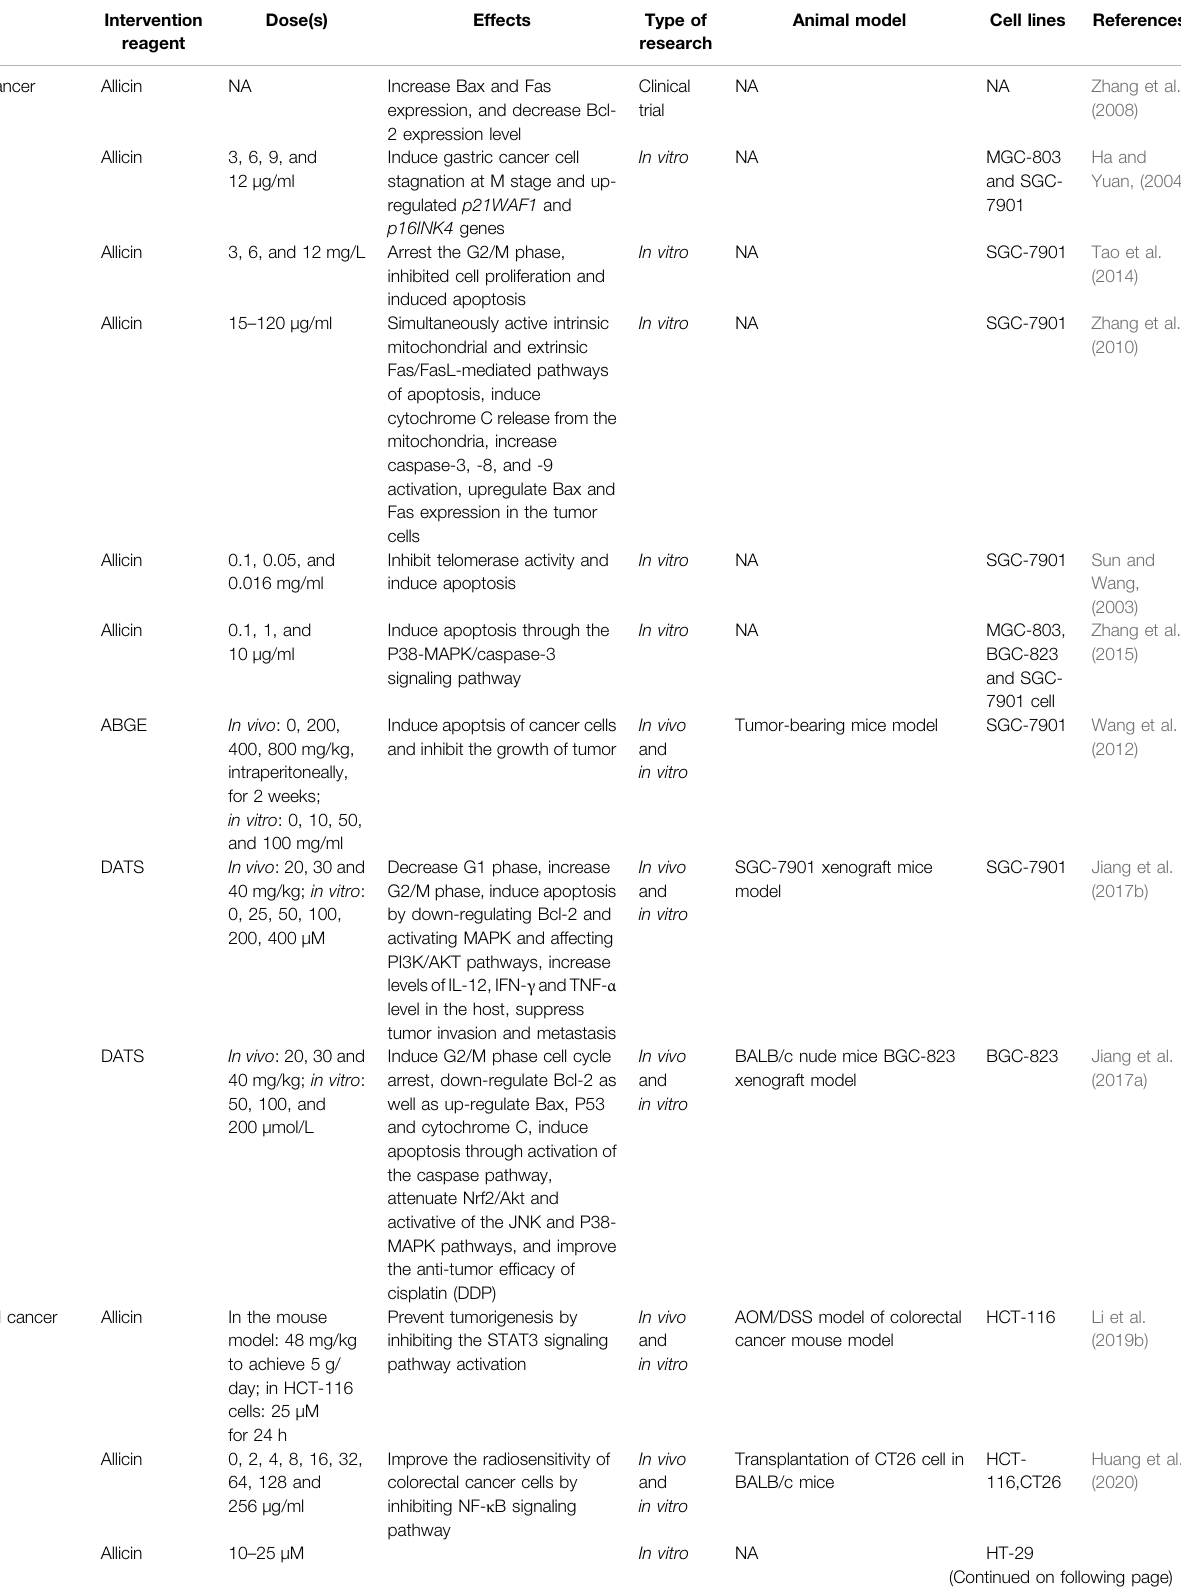
TABLE 1 | Summary of mechanisms of allicin and its secondary metabolites against cancers of digestive